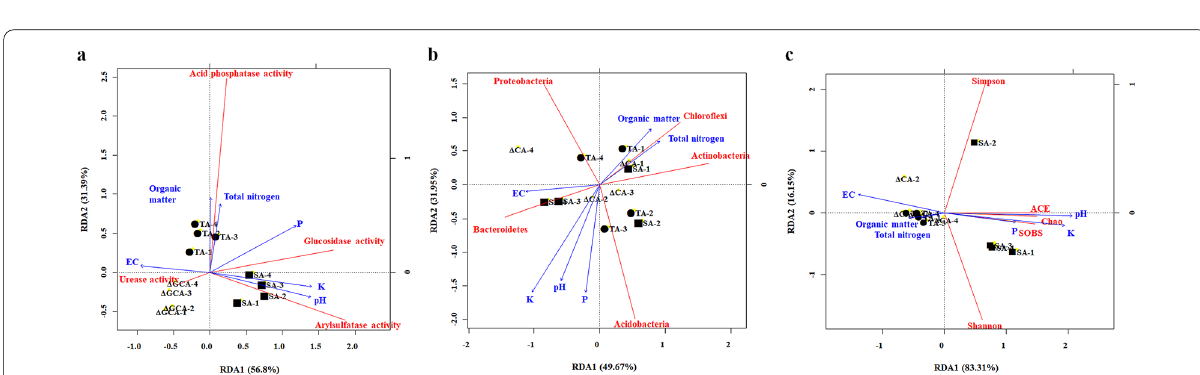
Fig. 8 Redundancy analysis for the soil parameters of the studied tea plantations. The correlation between the soil properties, and ( a ) enzymatic activities, ( b ) the most abundant bacterial phylum, and ( c ) alpha diversity of species was respectively analyzed by RDA. The RDAs were implemented by the R